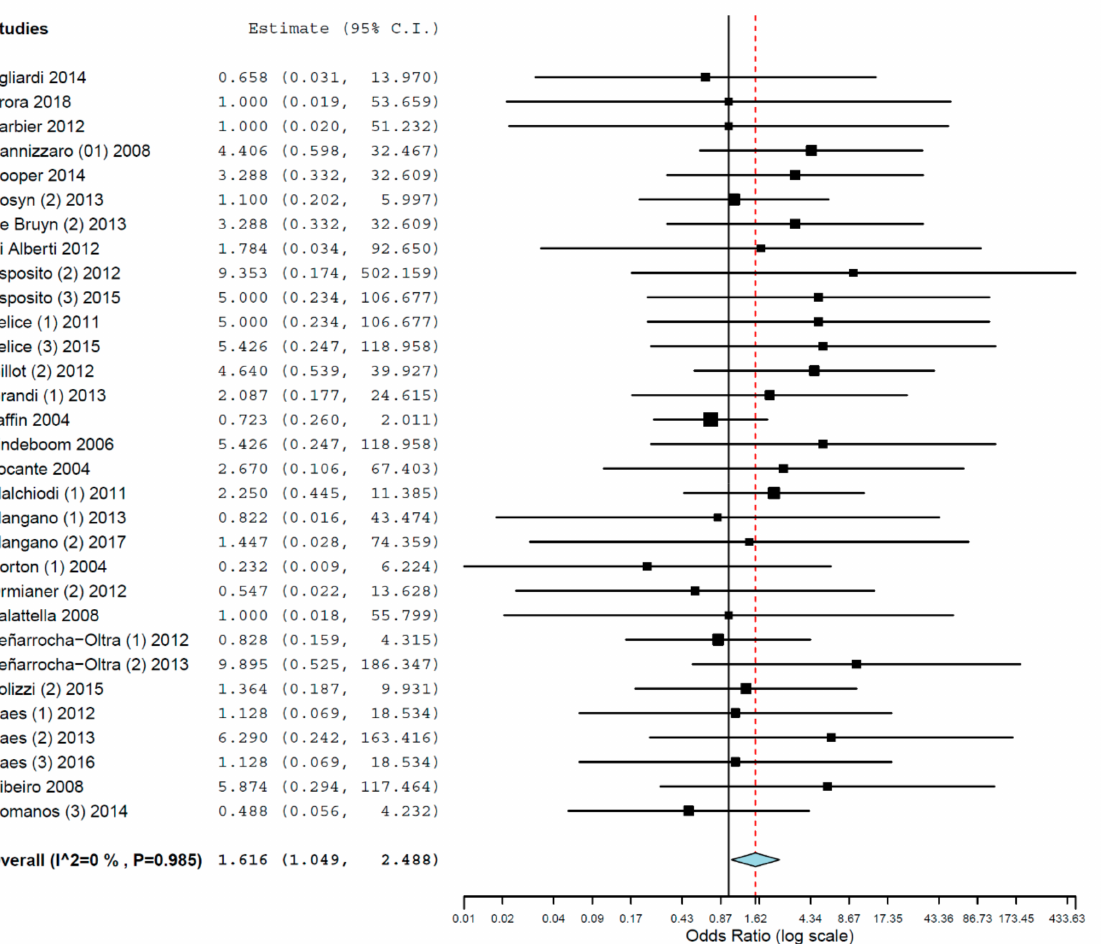
Figure 2. Forest plot for the event ‘implant failure’, studies evaluating implants inserted exclusively in maxillae. Estimate in Odds Ratio.